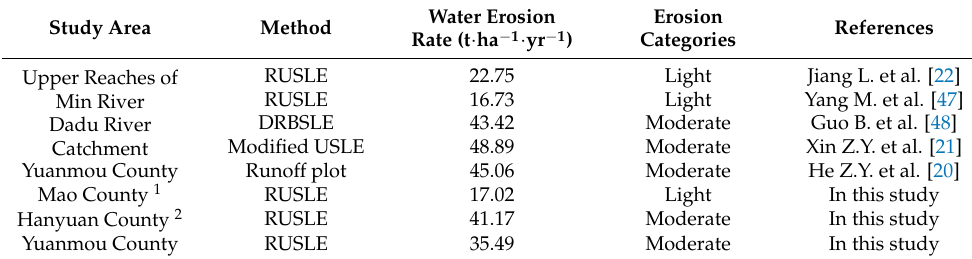
Table 5. Comparative validation of soil erosion rates in different